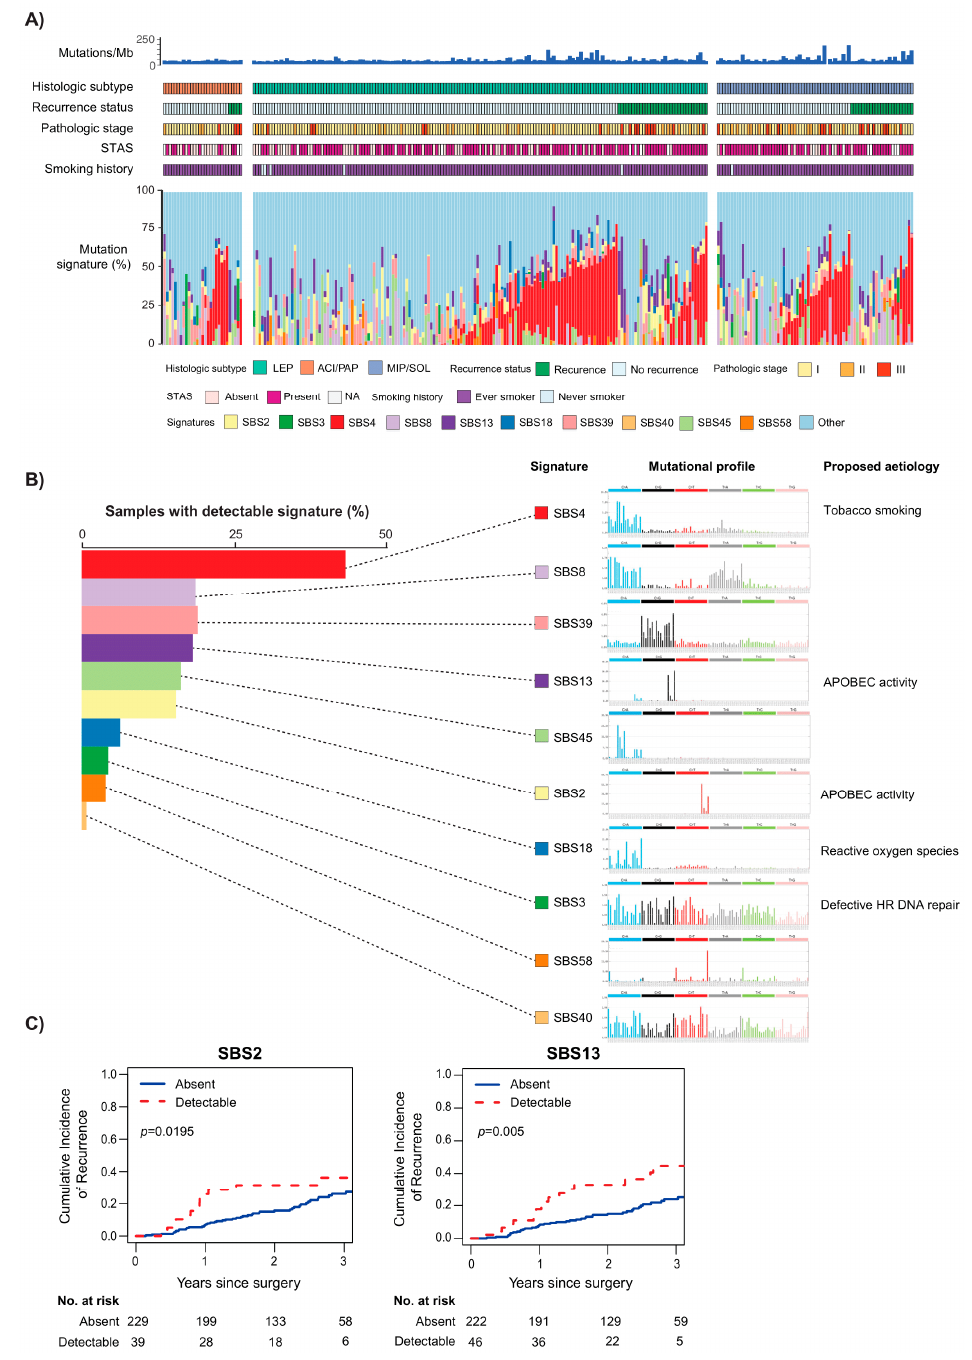
Figure 2. Analysis of somatic mutational signatures. ( A ) Bar plots of detectable mutational signatures (colored) by individual tumors. Tracks above the bar charts indicate (1) somatic mutations, (2) histologic subtype, (3) recurrence status, (4) pathologic stage, (5) tumor STAS, and (6) smoking history. ( B ) Distribution of select detectable signatures across all tumors and their representative mutational profiles and the proposed cause. ( C ) Cumulative incidence of postresection recurrence curves according to SBS2 and SBS13 mutational signature status across all patients. ACI, acinar; HR, homologous recombination; LEP, lepidic; MIP, micropapillary; NA, not available; PAP, papillary; SBS, single-base